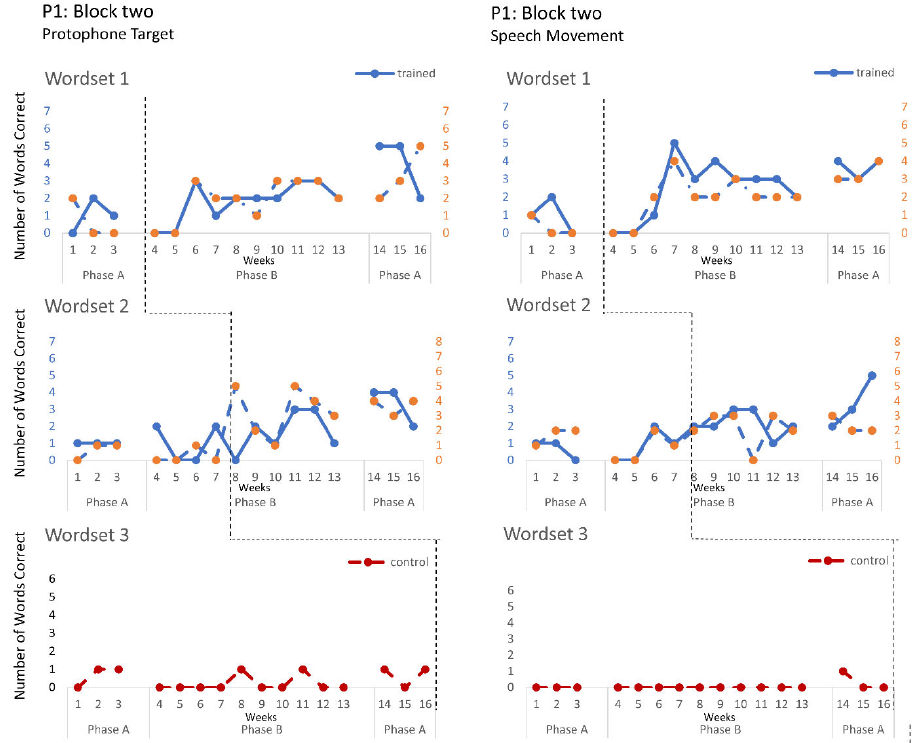
Figure 3. Accuracy of performance on the speech probes as scored for protophone target ( left ) and motor-speech movements ( right ) block two, participant 1.